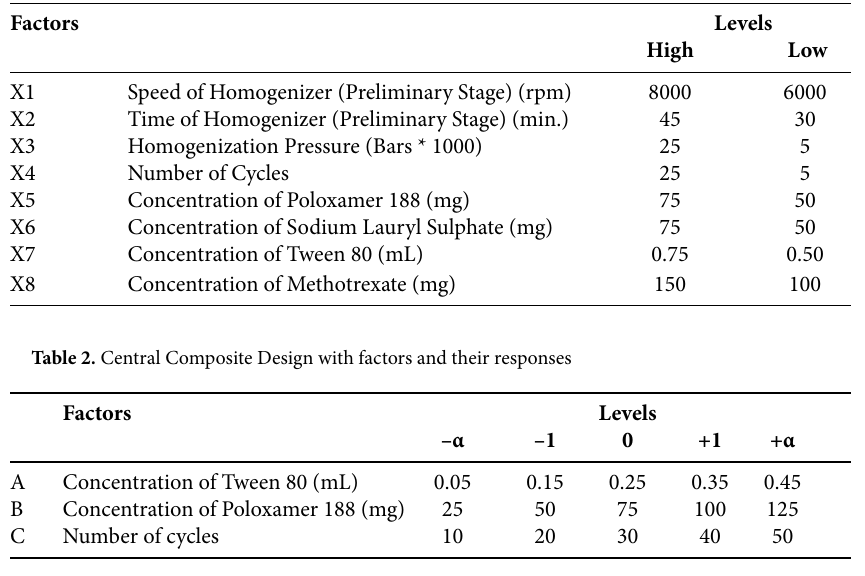
Time of Homogenizer (Preliminary Stage) (min.)